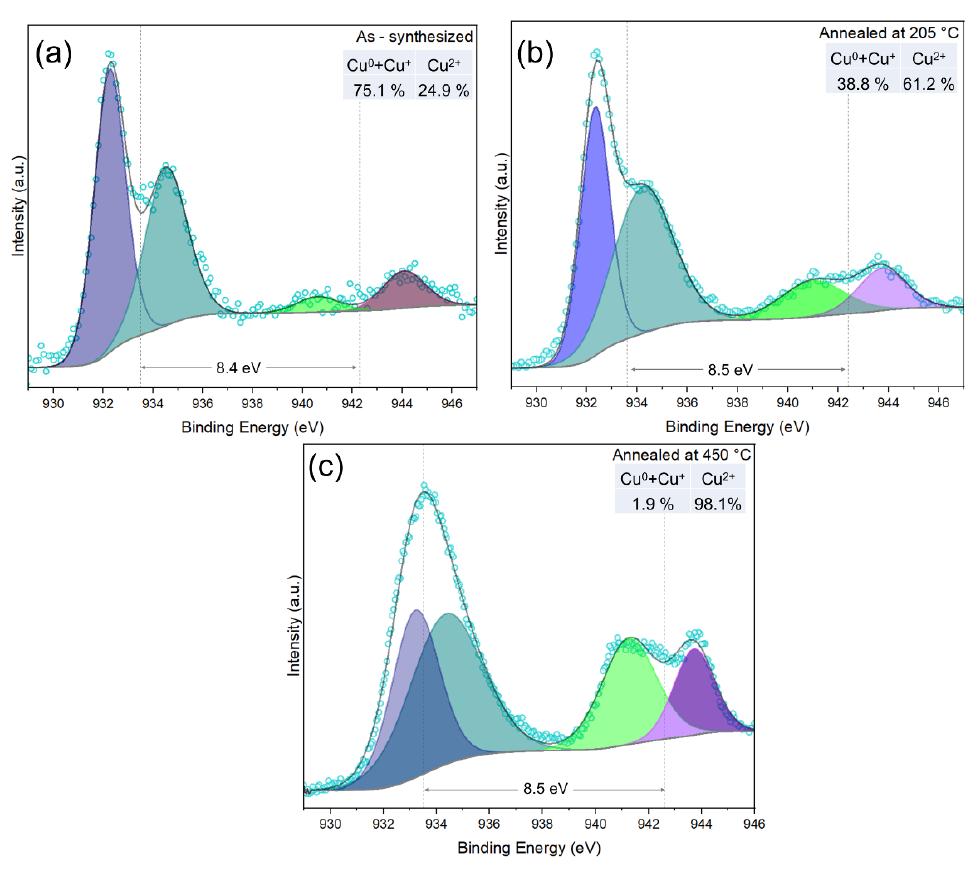
Figure 4. Cu 2p 3/2 core level XPS spectra and deconvolution curves for the ( a ) as-synthesized and annealed samples at ( b ) 205 °C and ( c ) 450°C. annealed samples at ( b ) 205 ◦ C and ( c ) 450 ◦